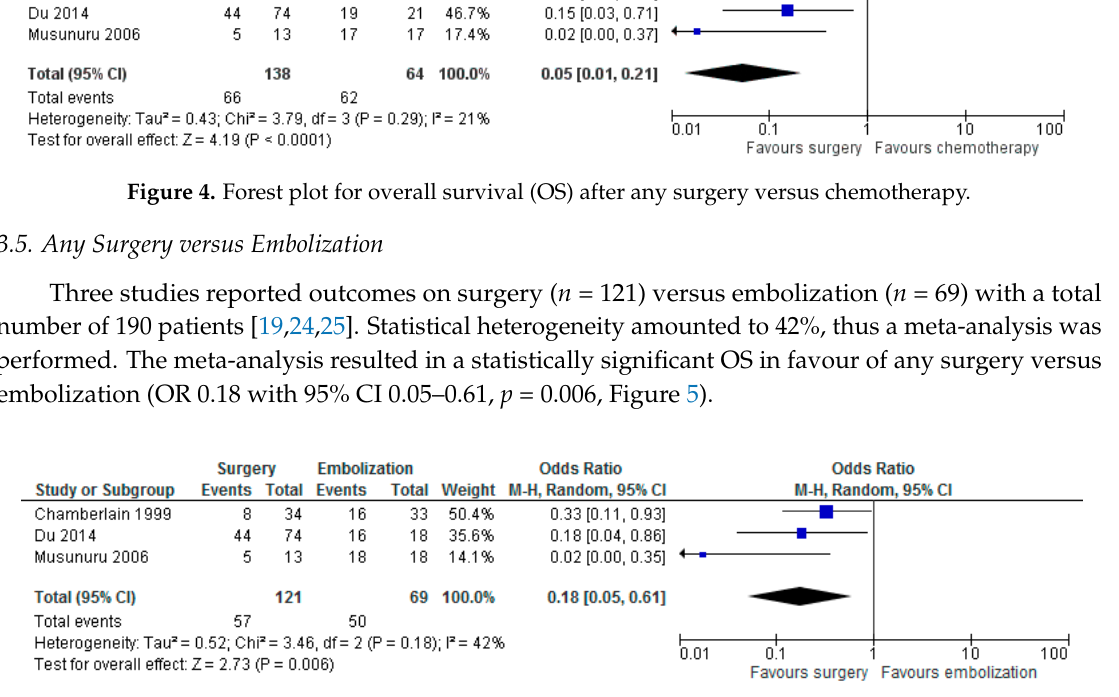
Figure 5. Forest plot for overall survival (OS) after any surgery versus embolization.